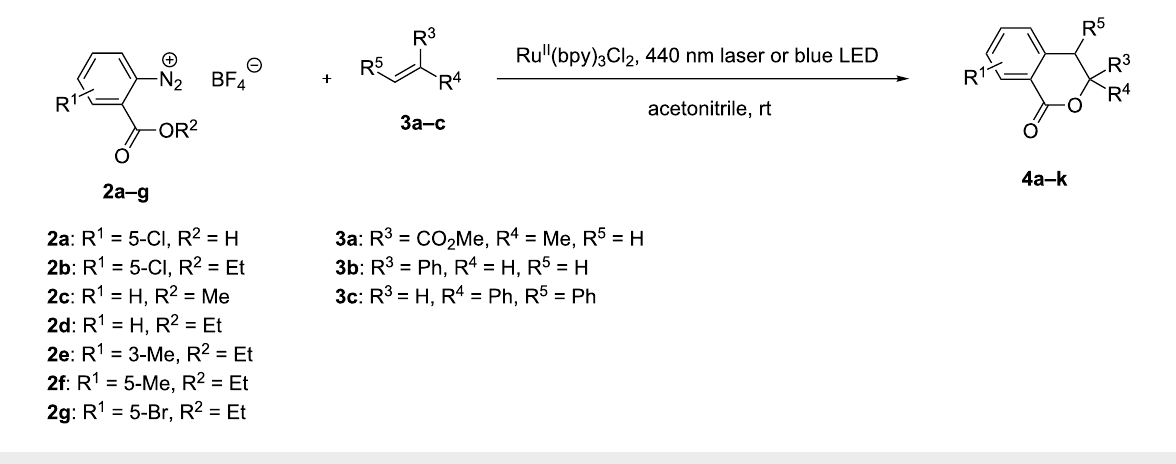
Scheme 2: Reaction of o -alkoxycarbonyldiazonium salts with alkenes under Ru-photocatalyzed conditions.